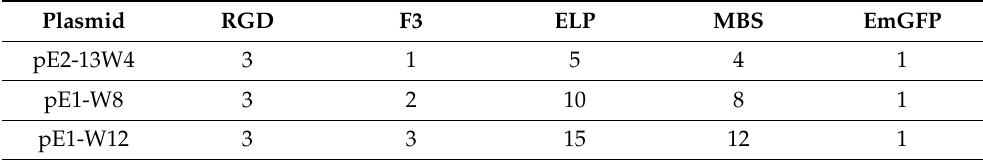
Table 4. The number of motifs in each plasmid.